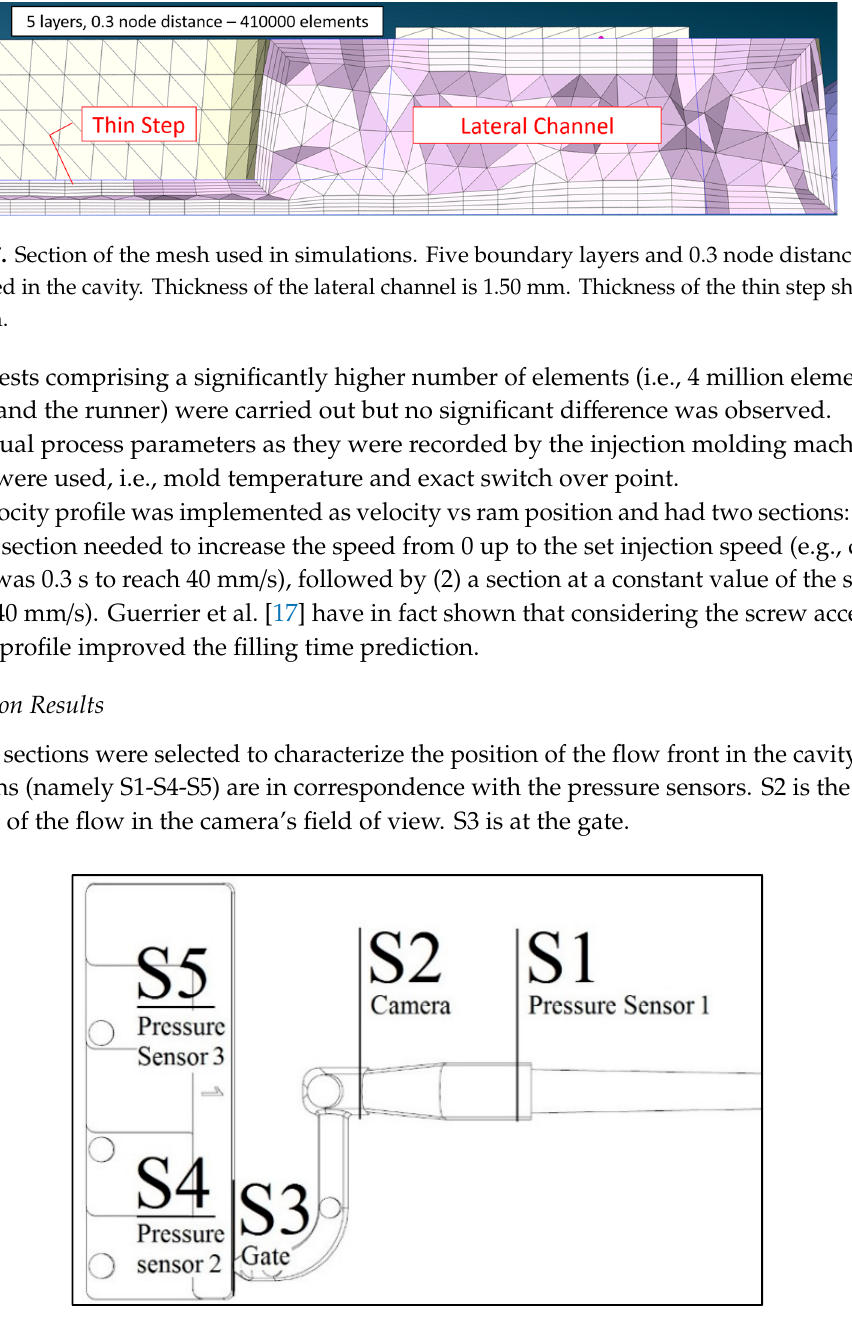
Figure 6. Model of the cavity (green), runner (purple) and screw (modelled as hot runner, indicated in orange).